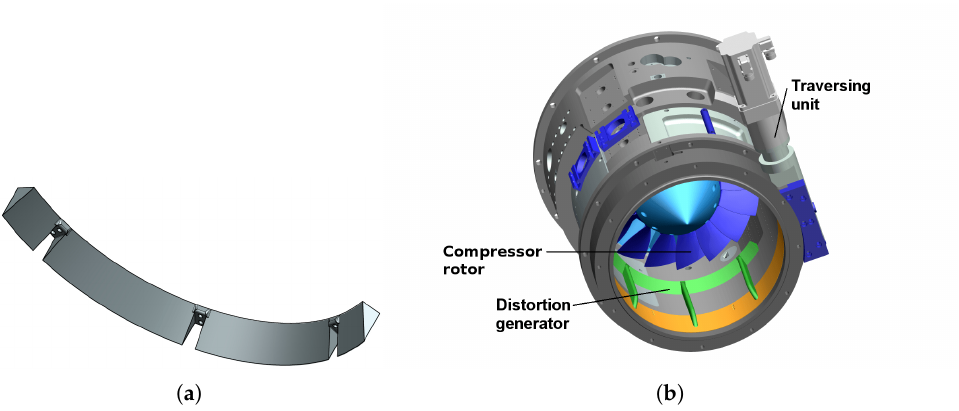
Figure 1. Distortion generator in detail and mounted at the test rig. ( a ) Distortion generator; ( b ) Test rig with mounted distortion generator (green).